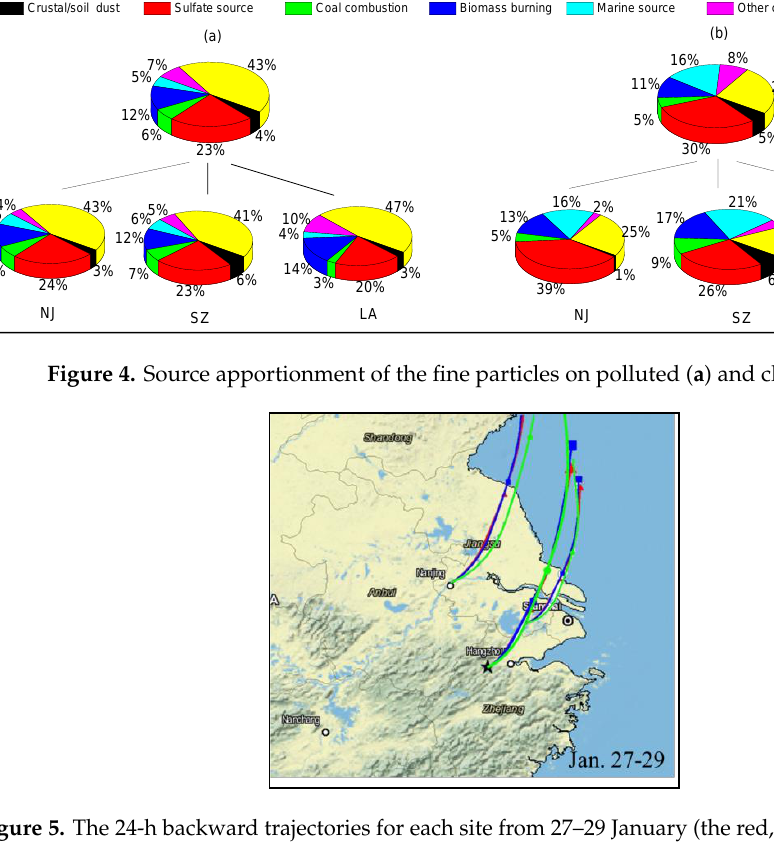
Figure 5. The 24-h backward trajectories for each site from 27–29 January (the red, blue and green lines represent the trajectories at 50, 100 and 500 m above ground level (AGL), respectively).